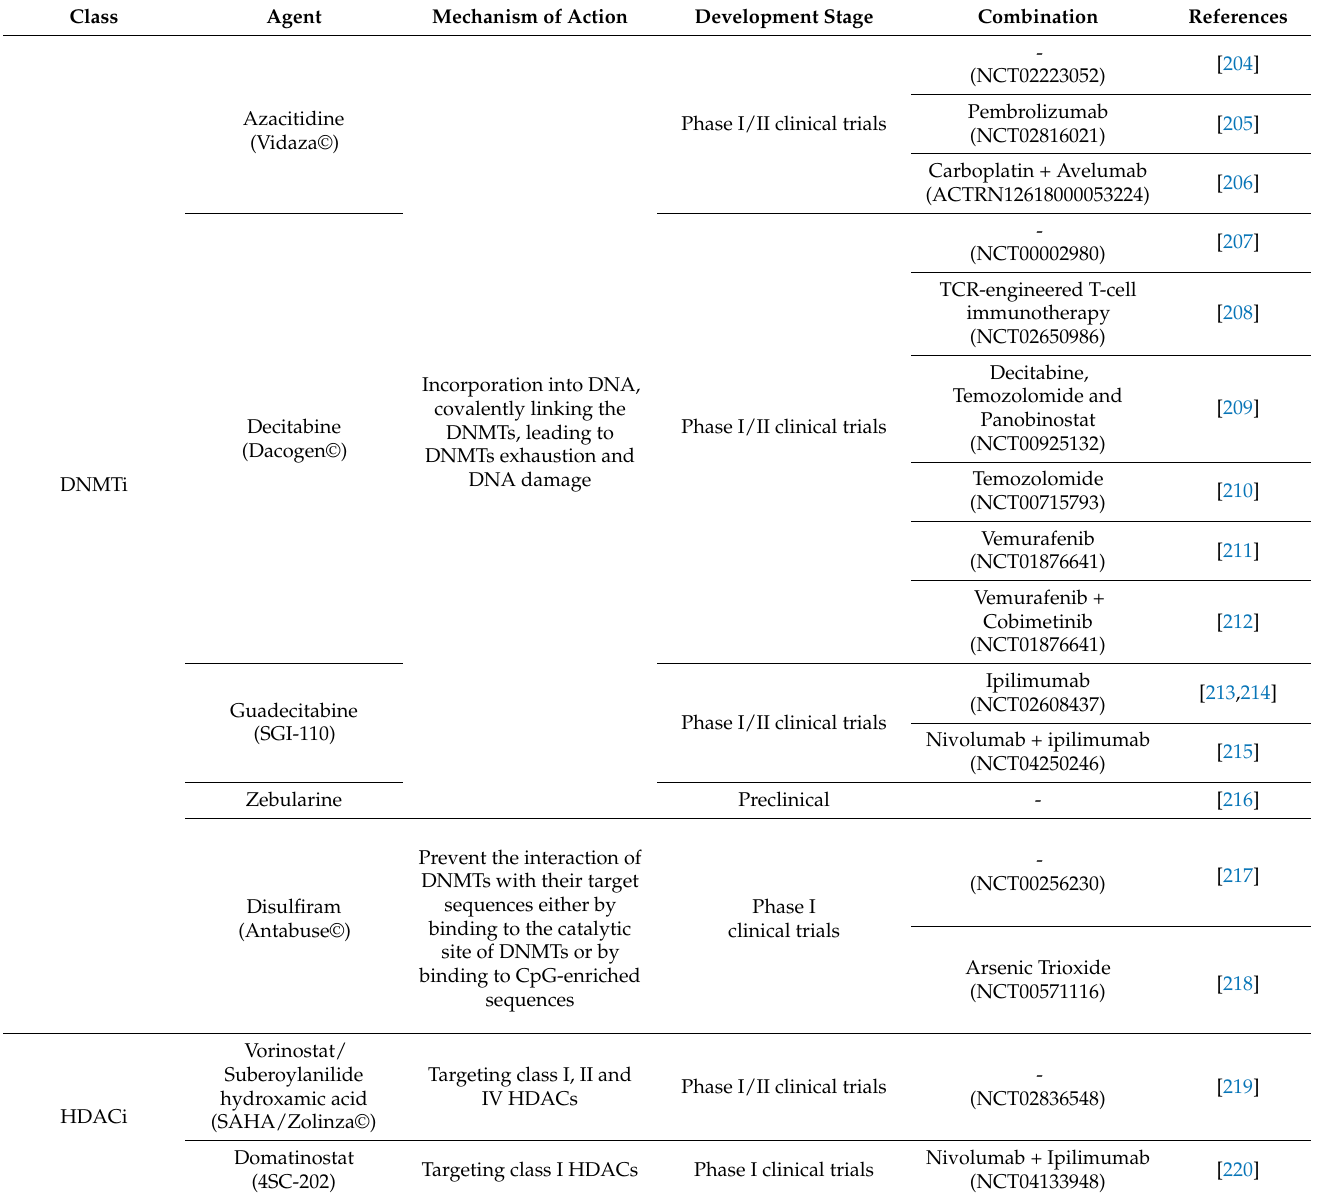
Table 1. Overview of the most common epigenetic inhibitors and their current status in CM 1